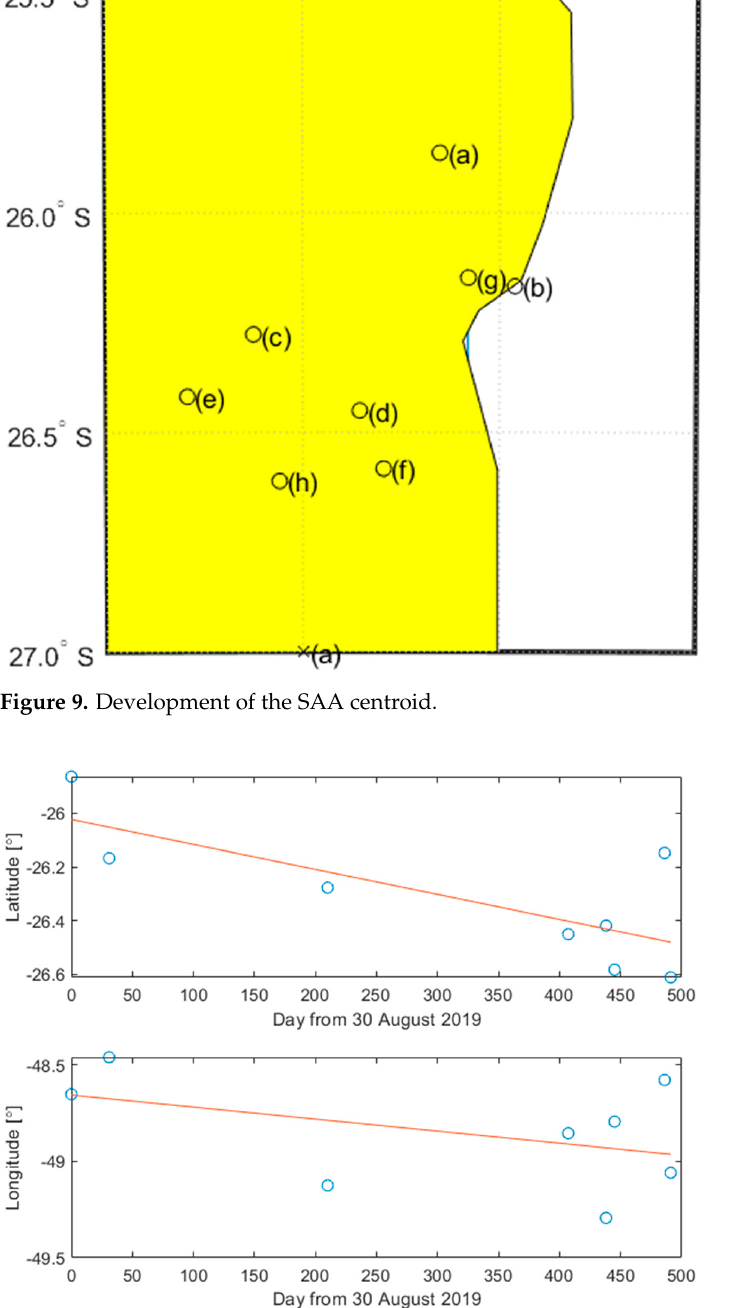
Figure 10. Straight line interpolation of the centroid position.